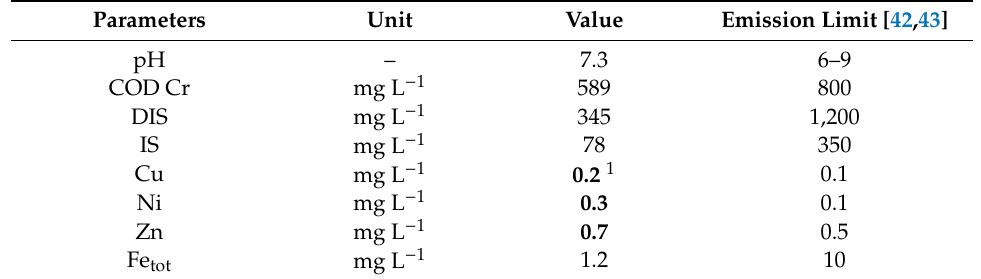
Table6. Resultsoftheanalysisdealingwithdischargefromthesedimentationtankintothesewersystem. Parameters